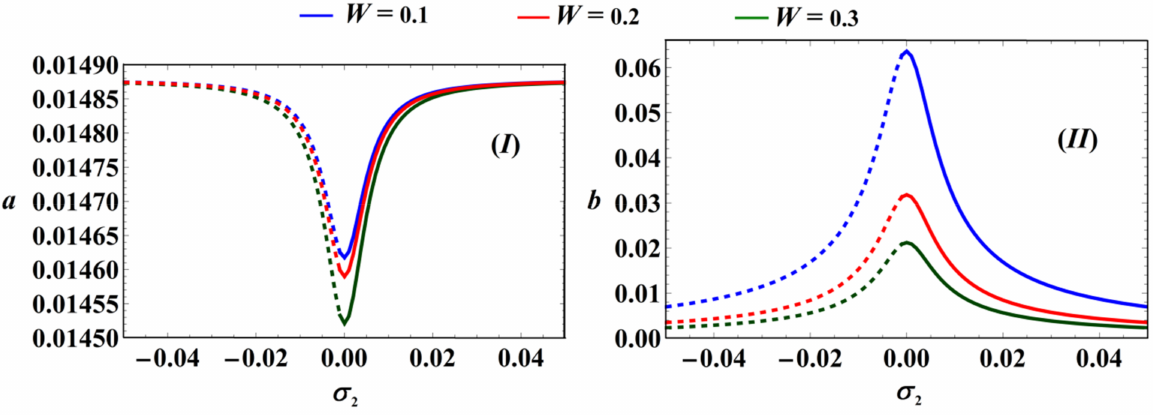
Figure 19. The frequency response at σ 1 = − 0.001, c 1 = 0.001, and c 2 = 0.011 of: ( I ) a ( σ 2 ) and ( II ) b ( σ 2 )